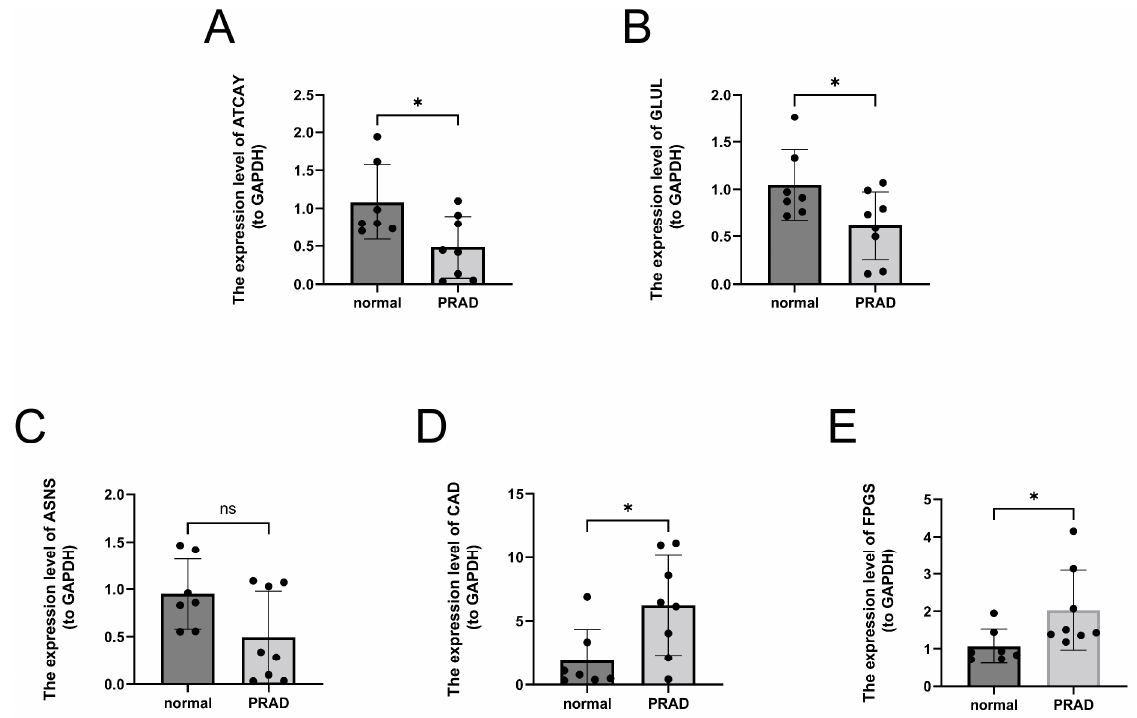
Figure 9. Experimental validation of five key genes’ expression levels in PCa clinical samples. ( A ) The mRNA expression level of ATCAY in mRNA expression levels of prognostic genes in PCa clinical samples. ( B ) The mRNA expression level of GLUL in mRNA expression levels of prognostic genes in PCa clinical samples. ( C ) The mRNA expression level of ASNS in mRNA expression levels of prognostic genes in PCa clinical samples. ( D ) The mRNA expression level of CAD in mRNA expression levels of prognostic genes in PCa clinical samples. ( E ) The mRNA expression level of FPGS in mRNA expression levels of prognostic genes in PCa clinical samples. * p < 0.05, ns repre- sents no significant difference.